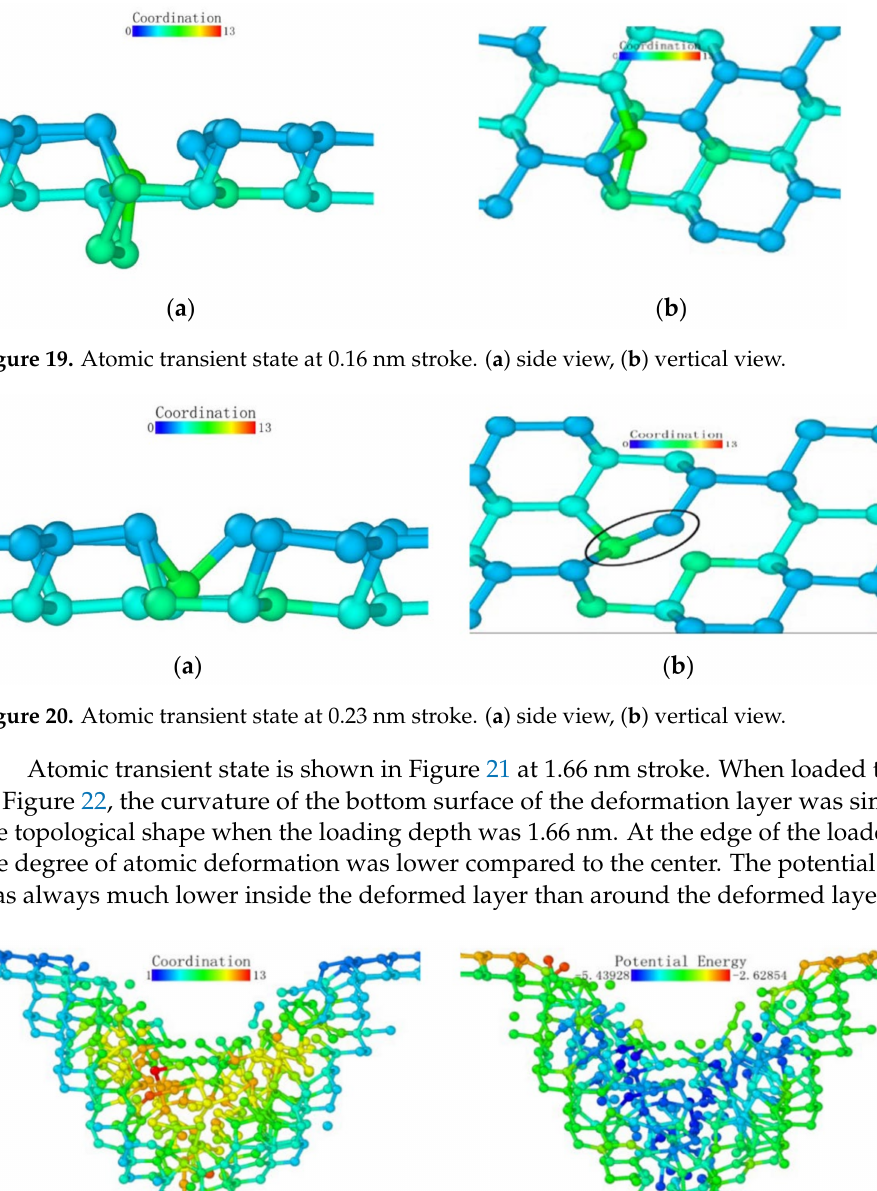
Figure 18. Atomic transient state at 0.15 nm stroke. ( a ) side view, ( b ) vertical view.